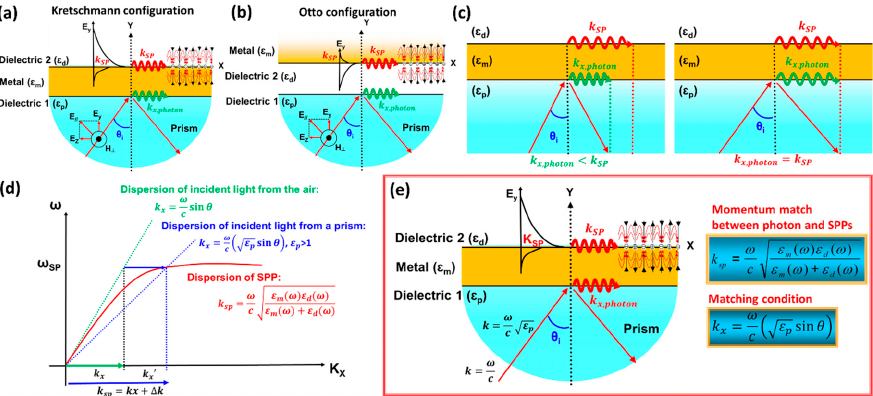
Figure 2. Configurations of the attenuated total reflection (ATR) method: ( a ) Otto configuration and ( b ) Kretschmann configuration. ( c ) The dispersion curve for a surface plasmon mode shows the momentum mismatch problem between the free space photon (k photon , gree line) and surface plasmon modes (k SP , red line). ( d ) Dispersion relation of surface plasmon with photon. ( e ) The same effect of momentum-supply can be achieved by corrugating the metallic surface in the so-called prism-coupled SPR. The resonance is by using evanescent wave produced in attenuated total reflection (ATR).